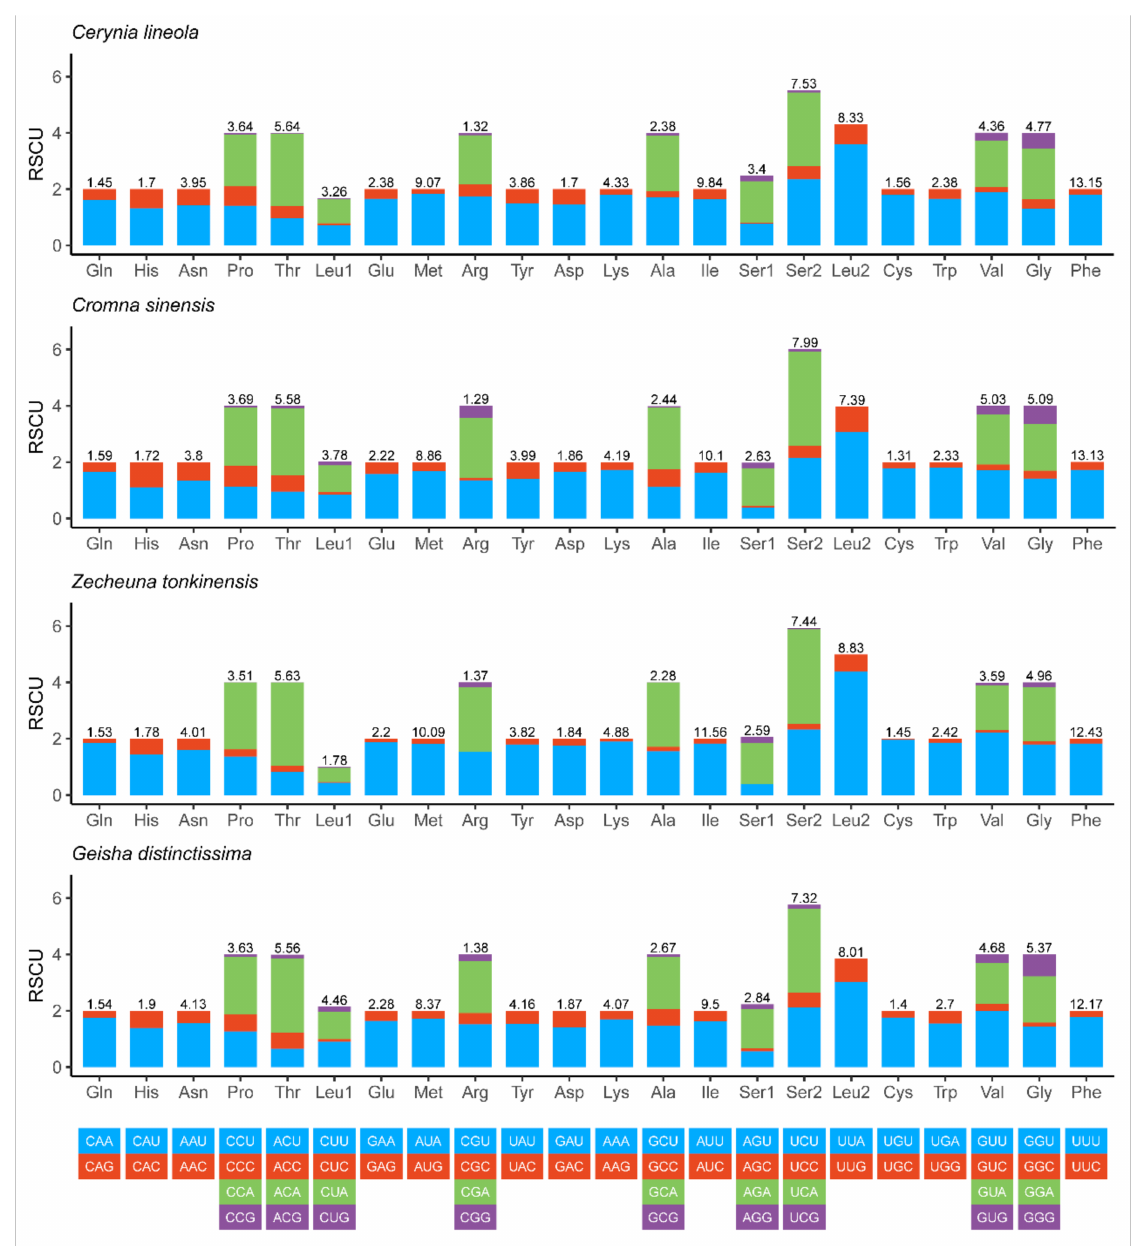
Figure 2. Relative synonymous codon usage (RSCU) of the mitogenomes of four Flatidae